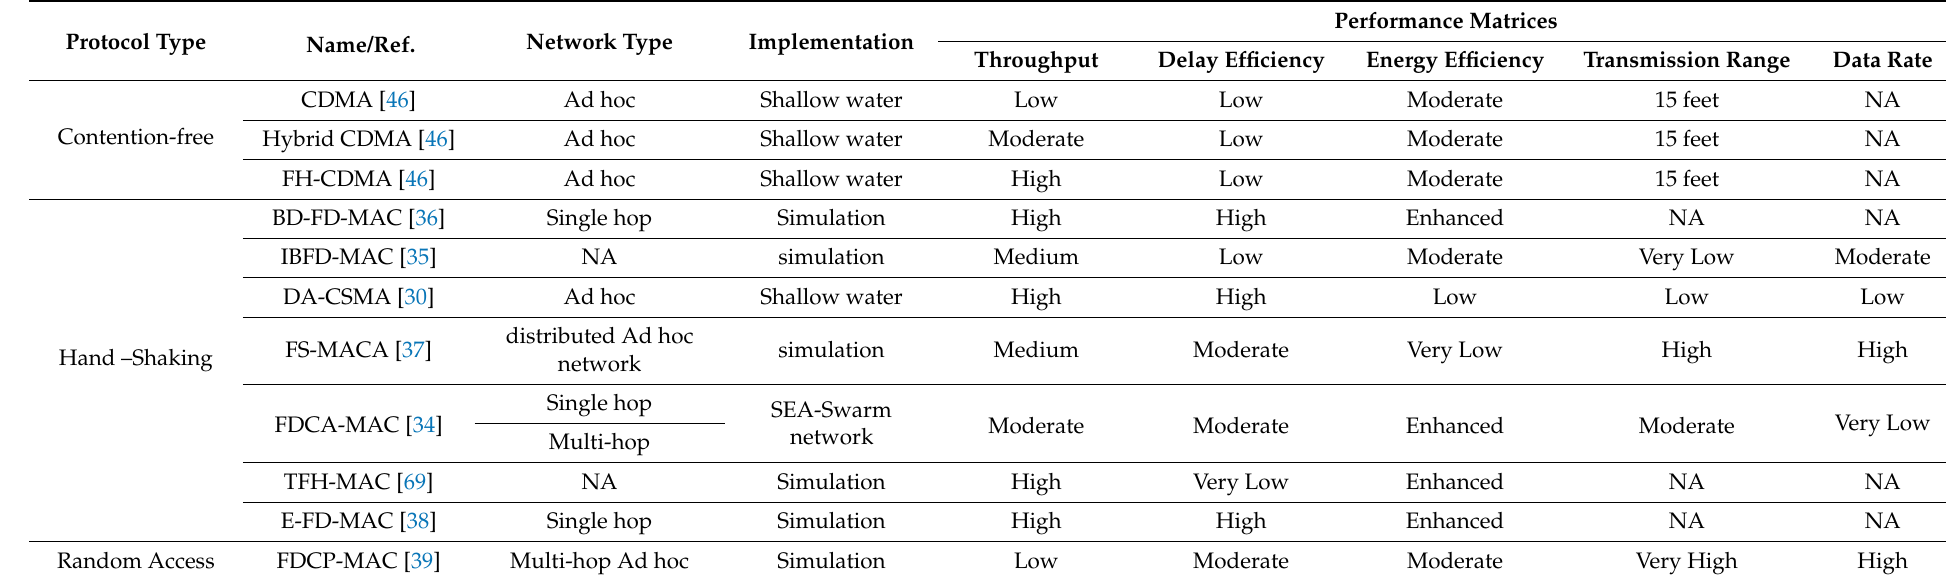
Table 5. Comparison of various FD-MAC layer-based UWAC